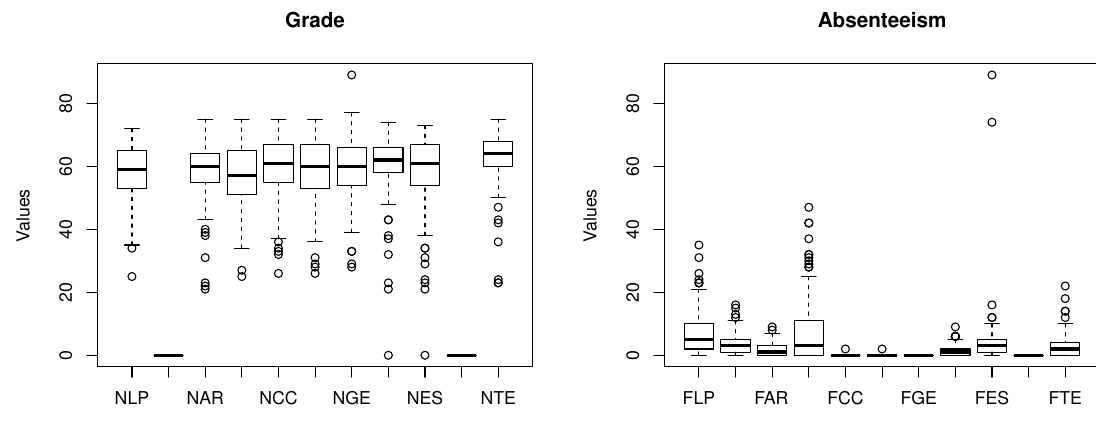
Figure 14. The variation of grade and absenteeism.